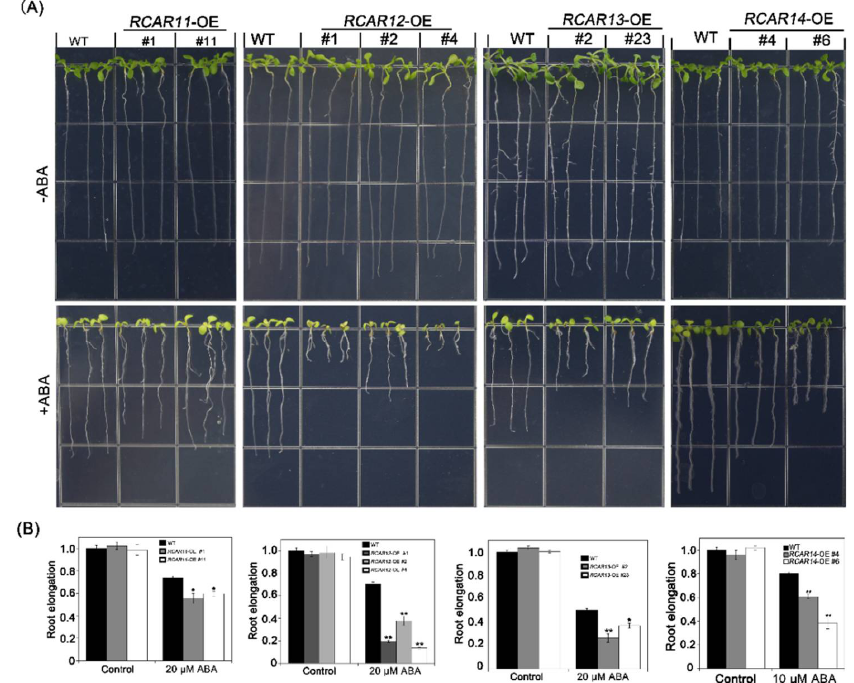
Figure 3. The overexpressions of the RCAR11/12/13/14 transgenic plants are ABA-hypersensitivity in root architecture. ( A ) The inhibition of root growth of the RCAR11/12/13/14 transgenic lines in the presence of 10 μM ABA. The 3-day-old seedlings grown on the MS medium were transferred to 1/2MS plates lacking or supplemented with 10 or 20 μM ABA. The photographs were taken 7 days after the transfer; ( B ) The statistical analysis of the root length of the different genotypes described in (A). Values are means ± SD ( n = 20). The experiments were repeated three times with similar results (* p < 0.05, ** p < 0.01, Student’s t -test).